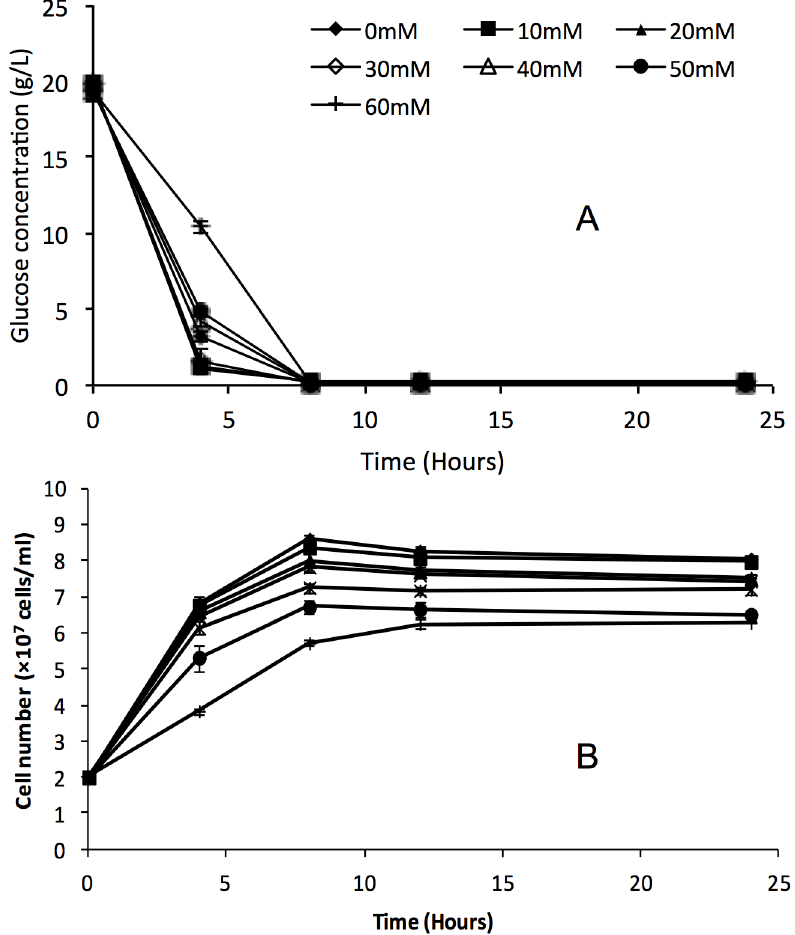
Fig 4. Time course profiles of glucose consumption (A) and cell growth curve (B) of Saccharomyces arboricolus 2.3319 in fermentation using YPD medium and formic acid (0 – 60 mM). Values are the mean of three experiments and vertical error bars represent standard